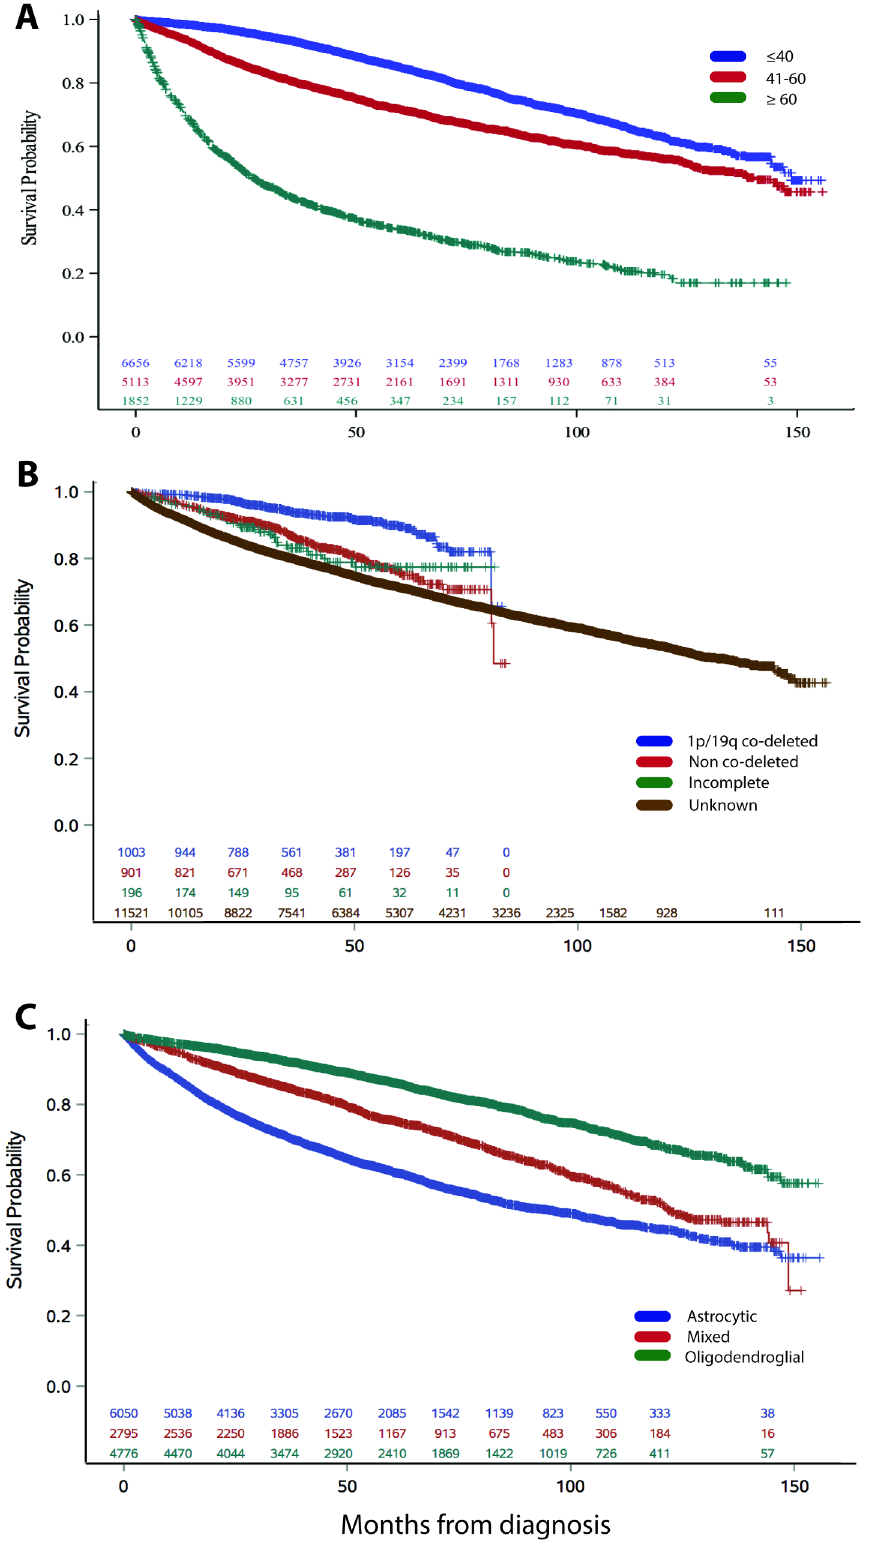
Fig 2. A. Survival by age group. B. Survival by 1p/19q co-deletion status. C. Survival by histology group.